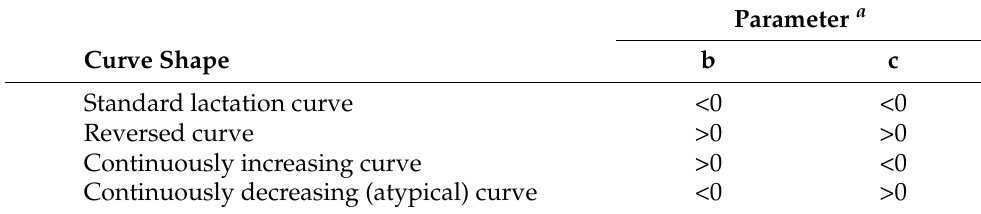
Table 2. Theoretical curve shapes fitted by the Wilmink